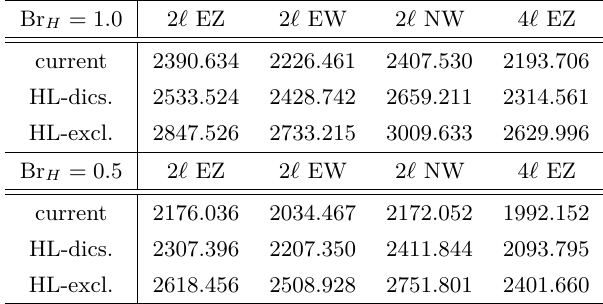
Table 7 . Lower bounds on the Higgs mass m H = m A in GeV. where Br H is the branching fraction of the corresponding decay mode of the Higgs boson. m e